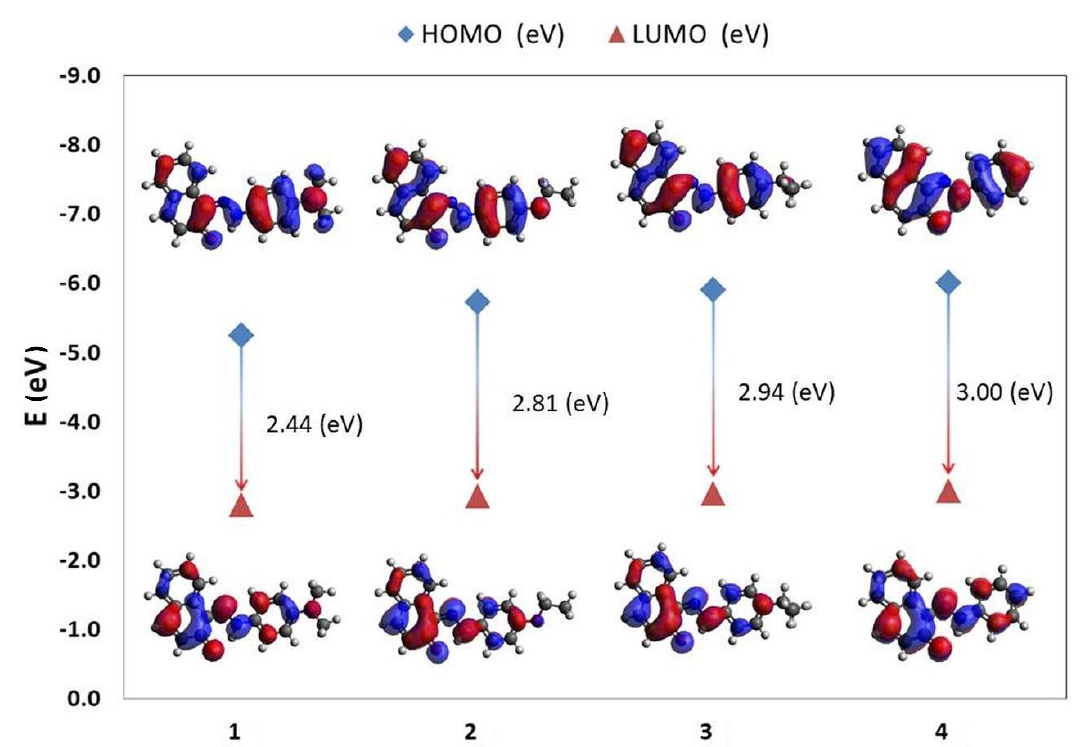
Figure 9. Graphic representation of HOMO and LUMO orbitals for hydrazone forms of 1-phenylazonaphthalen-2-ols ( 1–4 ) calculated in DMSO. Table 4. The values of hardness (η), energy gap, and energies of HOMO and LUMO orbita ls esti- mated for all compounds 1 – 8 .